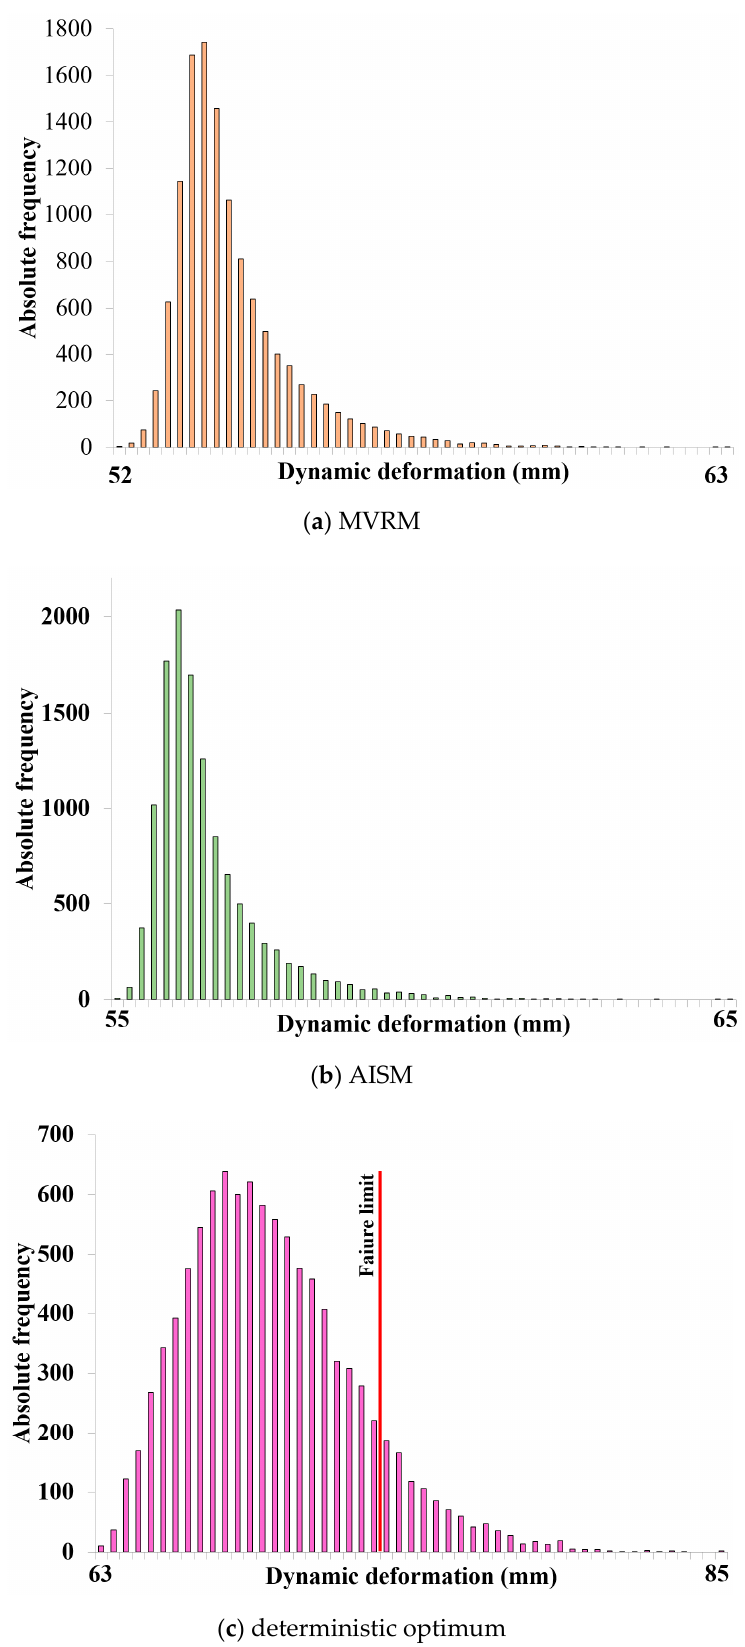
Figure 12. Comparison of PDF results for constraint function—dynamic deformation .